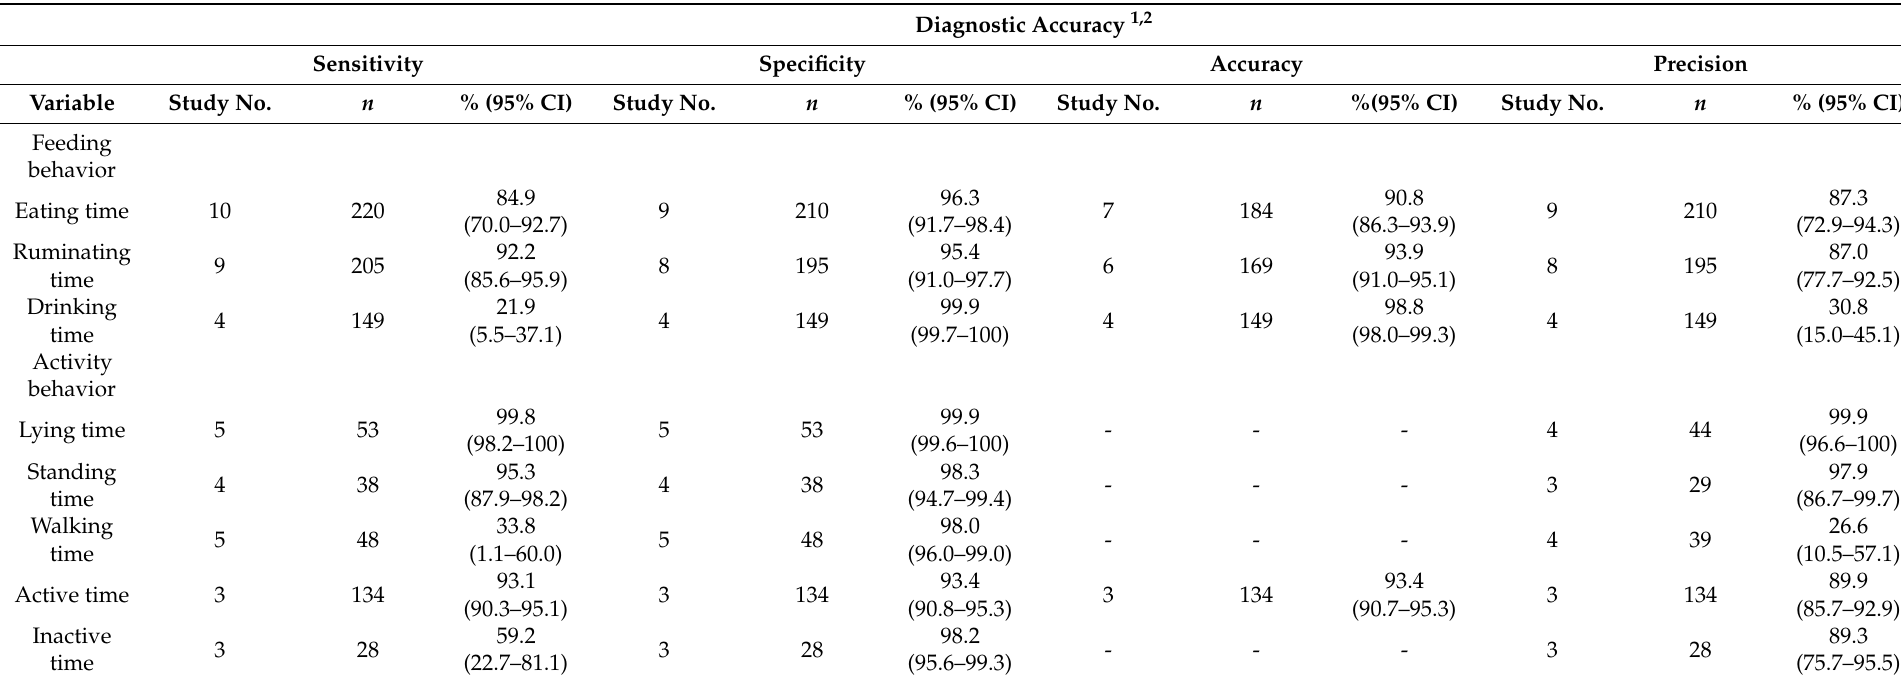
Table 10. Meta-analysis results of diagnostic accuracy of feeding and activity behavior variables from wearable